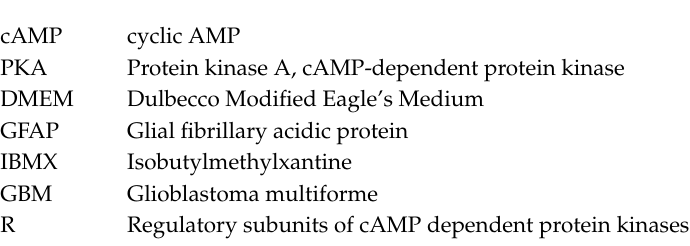
Table S1: Patients; Table S2: summary of results in the various tumors; Figure S1: relative expression of PKA regulatory subunits and survival data; Figure S2: immunocytochemistry on primary cultures; Figure S3: PKA in GBM samples; Figure S4: PKA R2 in different brain tumors; Figure S5: PKA R1 and catalytic subunit in various brain